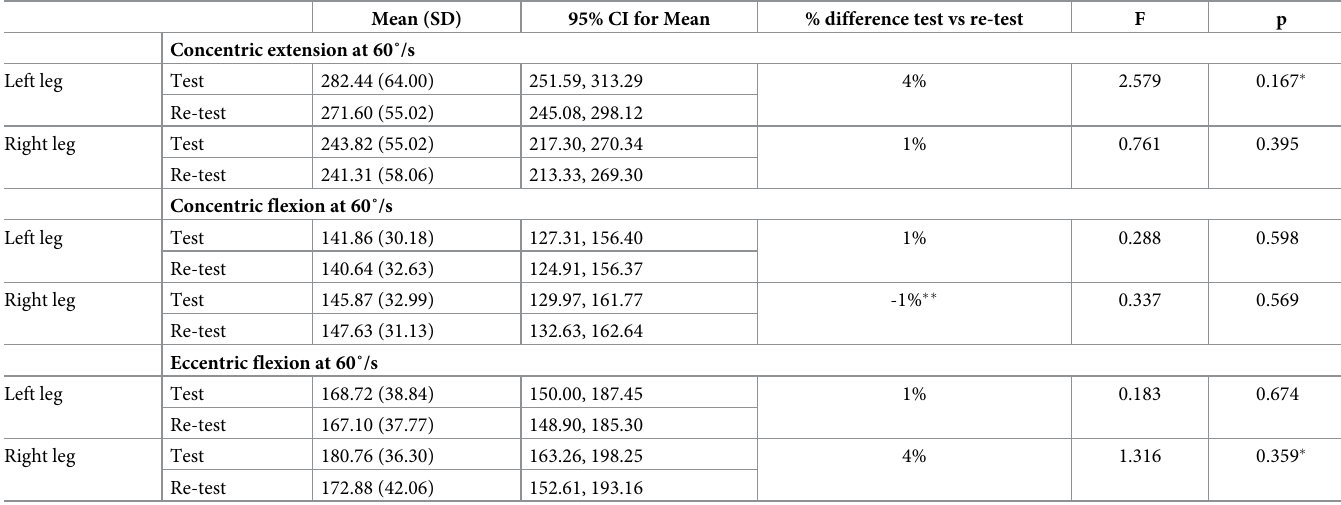
Table 1. Peak torque on test and retest.